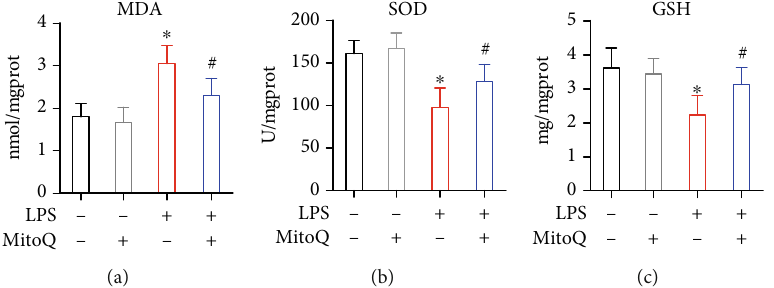
Figure 4: The e ff ects of MitoQ on intestinal oxidative stress in sepsis. The e ff ects of MitoQ on MDA, SOD, and GSH in the intestinal mucosa following LPS infection. Data are expressed as the mean ± SD . ∗ P < 0 : 05 vs. control group; # P < 0 : 05 vs. LPS group.